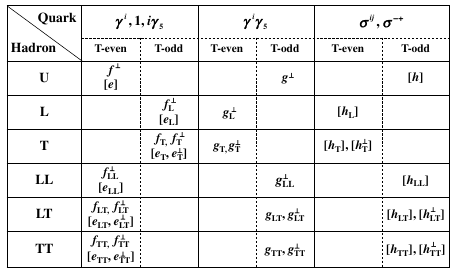
Table 2: Twist-3 TMDs.